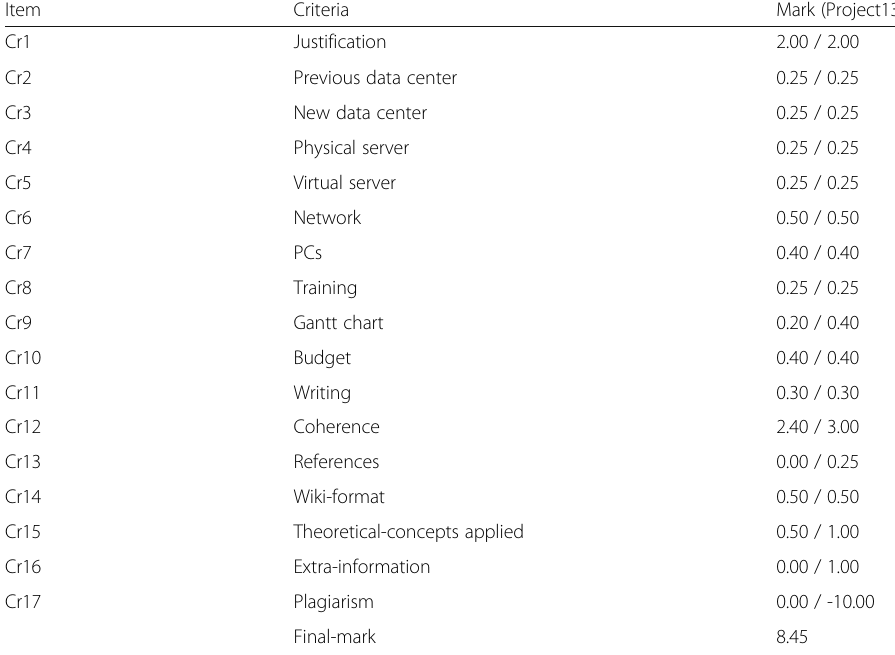
Table 4 Marks the teacher gave to the Project13 Item